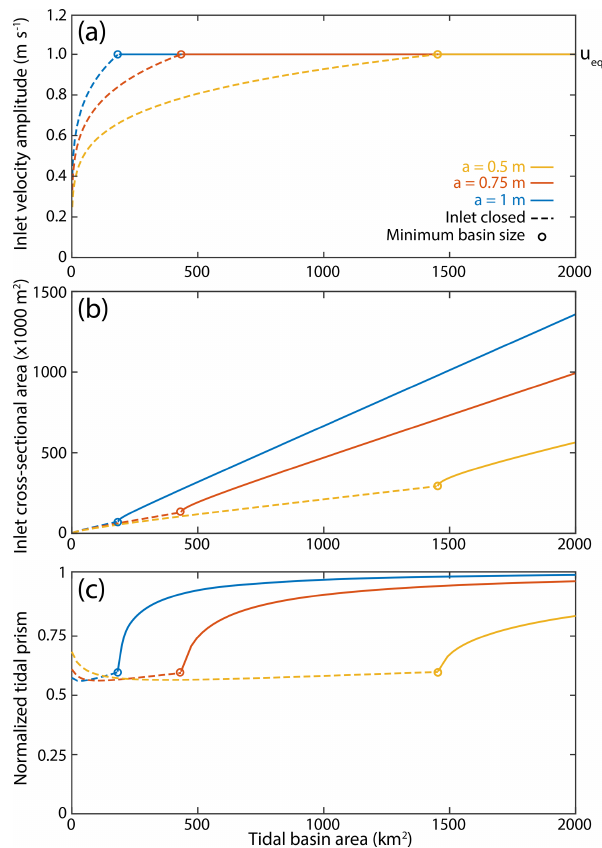
Figure 4. Analytical solutions to the equations that govern tidal in- let size (Eq. 21) as a function of tidal basin area and offshore tidal amplitude, illustrating that (a) inlets close if a velocity amplitude of 1ms − 1 cannot be maintained, (b) inlet cross-sectional area is de- pendent on tidal amplitude and tidal basin area, and (c) lagoon and inlet friction reduce the volume of water transported through the in- let, which is less than the potential tidal prism (offshore tidal range multiplied by intertidal